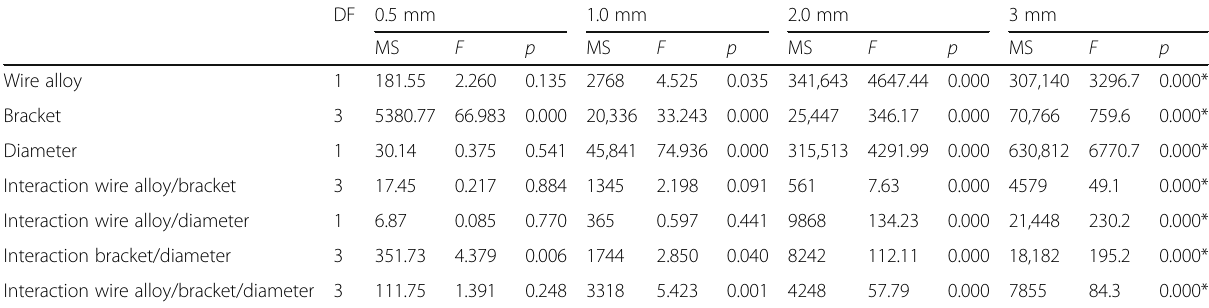
Table 2 Three-way ANOVA for comparison of wire, bracket, and interaction wire/bracket in the different deflections